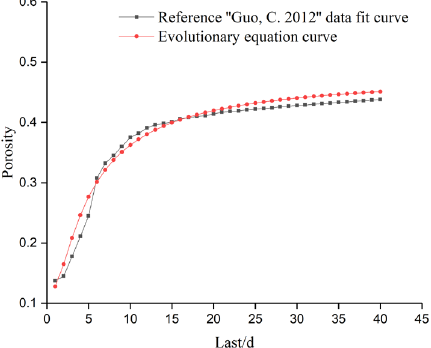
Figure 7. Comparison of porosity variation [34].